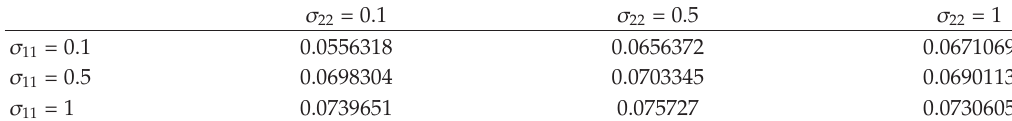
Table 2: MSV of filtering errors x 2 (cid:5) k (cid:6) − (cid:11) x 2 (cid:5) k/k (cid:6) , k (cid:7) 1 , 2 ,..., 200. σ 22 (cid:7) 0 .